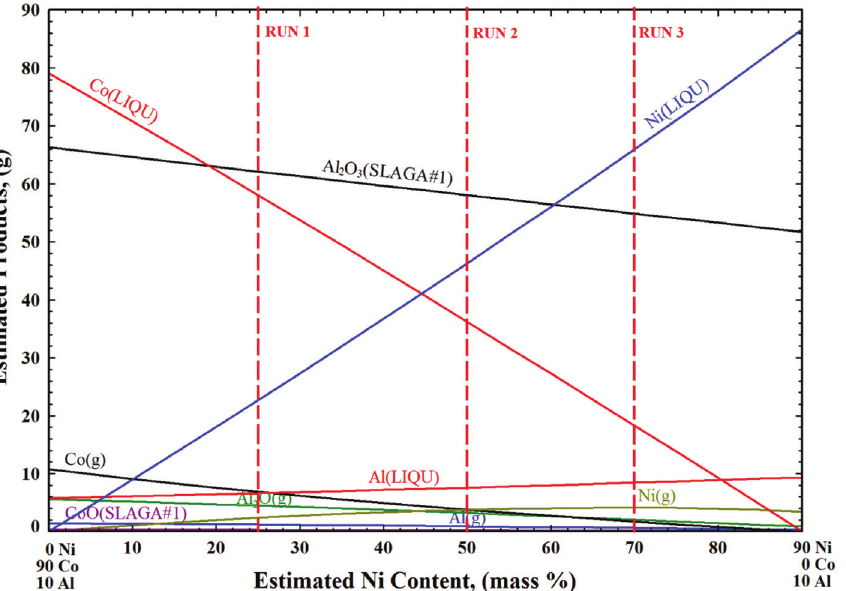
Fig. 2: Estimated final products of SHS reactions with changing in estimated Ni contents in the final alloy while Al content fixed as 10 mass%